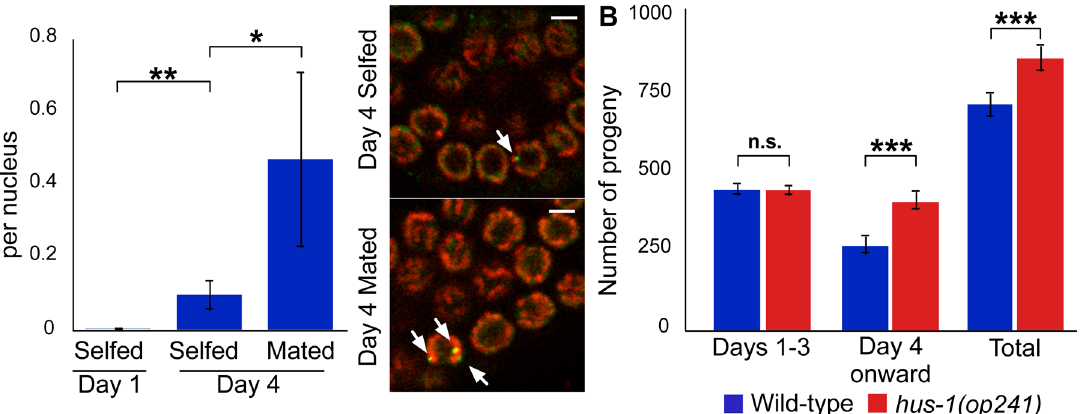
Fig 4. DDR increases with past reproductive activity and curtails reproductive capacity. (A) Average number of RPA-1::YFP foci per nucleus in late pachytene. Image panels show example RPA-1 foci (arrows; YFP: green; DNA: red). Scale bars: 2.5 μ m. For statistical tests see S4A Table. (B) Total brood size is larger for mated hus-1(op241) (red bar) than for mated wild-type (blue bar). For statistical tests see S4B Table. Error bars represent 83% confidence intervals; asterisks indicate significance of Wilcoxon rank sum test p ‑ value. To test whether the DDR curtails reproductive activity, we utilized the hus-1 reduction of function allele op241 . This mutation abrogates multiple forms of DDR [30] but preserves normal reproductive activity in selfed worms [31]. Mated hus-1(op241) hermaphrodites had a significantly larger brood size than wild-type controls (S4B Table and Fig 4B); the reproductive schedule was almost identical between days 1 and 3, but from day 4 onward op241 had a ~1.5-fold greater number of progeny. This shows that the DDR hastens reproductive senescence, by a mechanism that remains to be